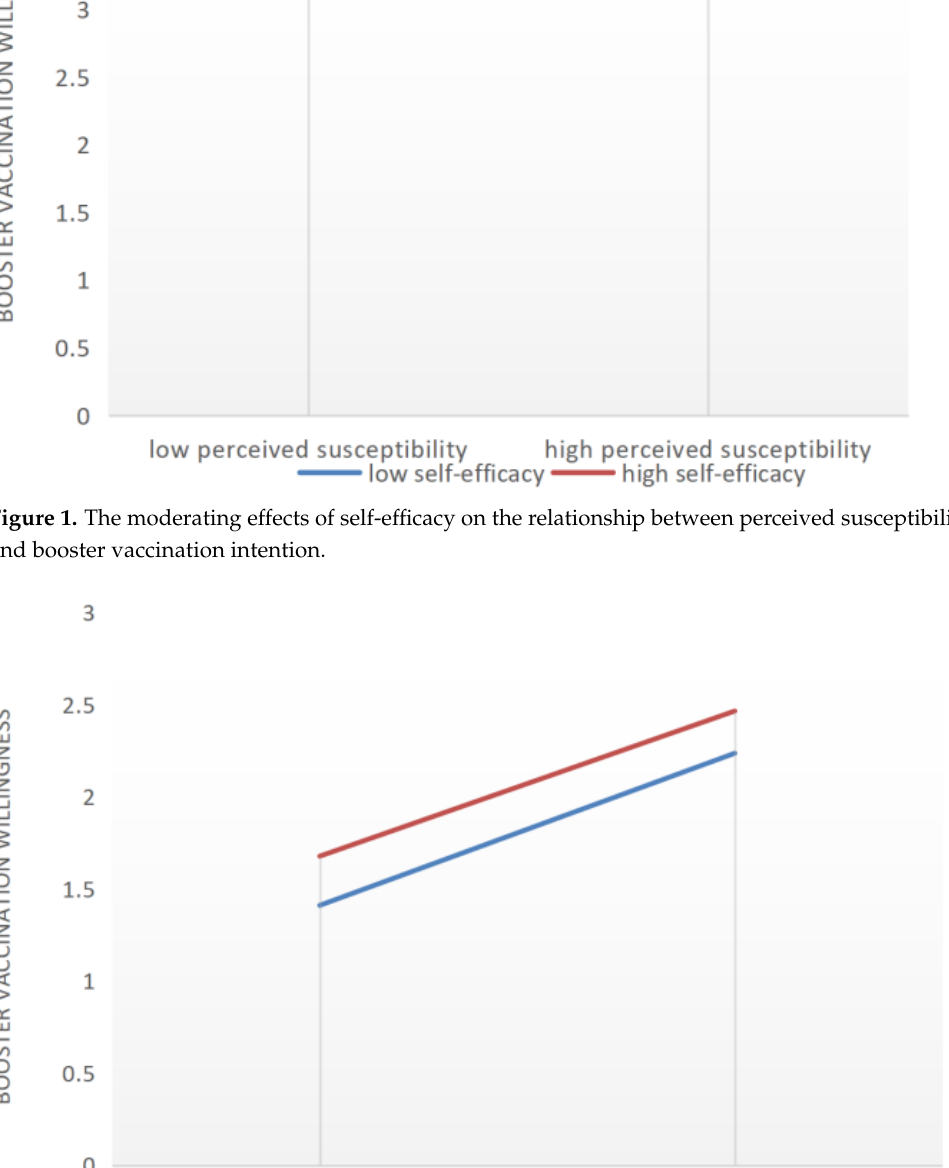
Figure 3. The moderating effects of self-efficacy on the relationship between perceived barriers and booster vaccination intentions.